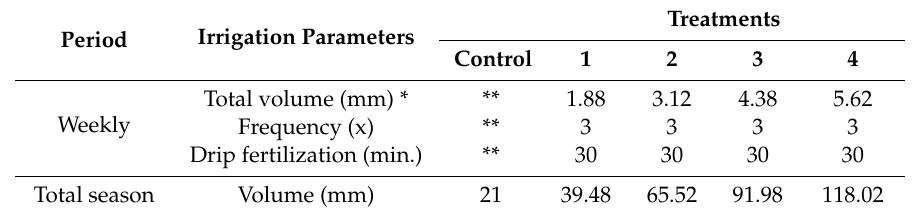
Table 2. Irrigation treatments applied on the experimental plot in summer 2016, per week and total season. Period Irrigation Parameters